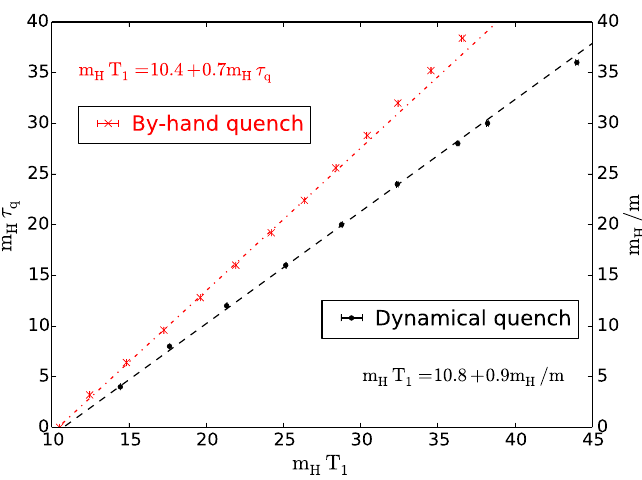
Figure 2 . The relation between quench time T 1 and (cid:28) q and m (cid:0) 1 , respectively. Even when the mass (cid:13)ip is instantaneous, the Higgs takes a (cid:12)nite time (about 10 m (cid:0) 1